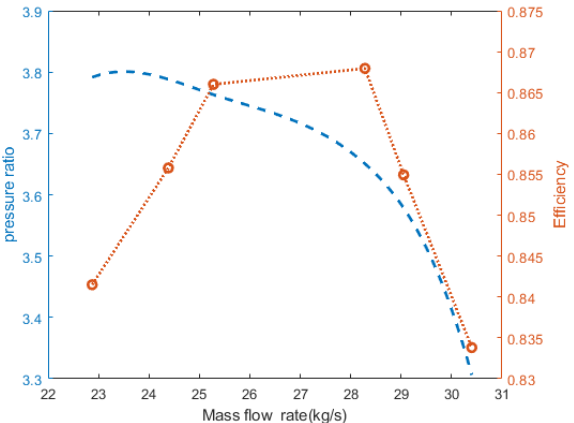
Figure 3. Pressure ratio and efficiency characteristic curves of the centrifugal compressor.